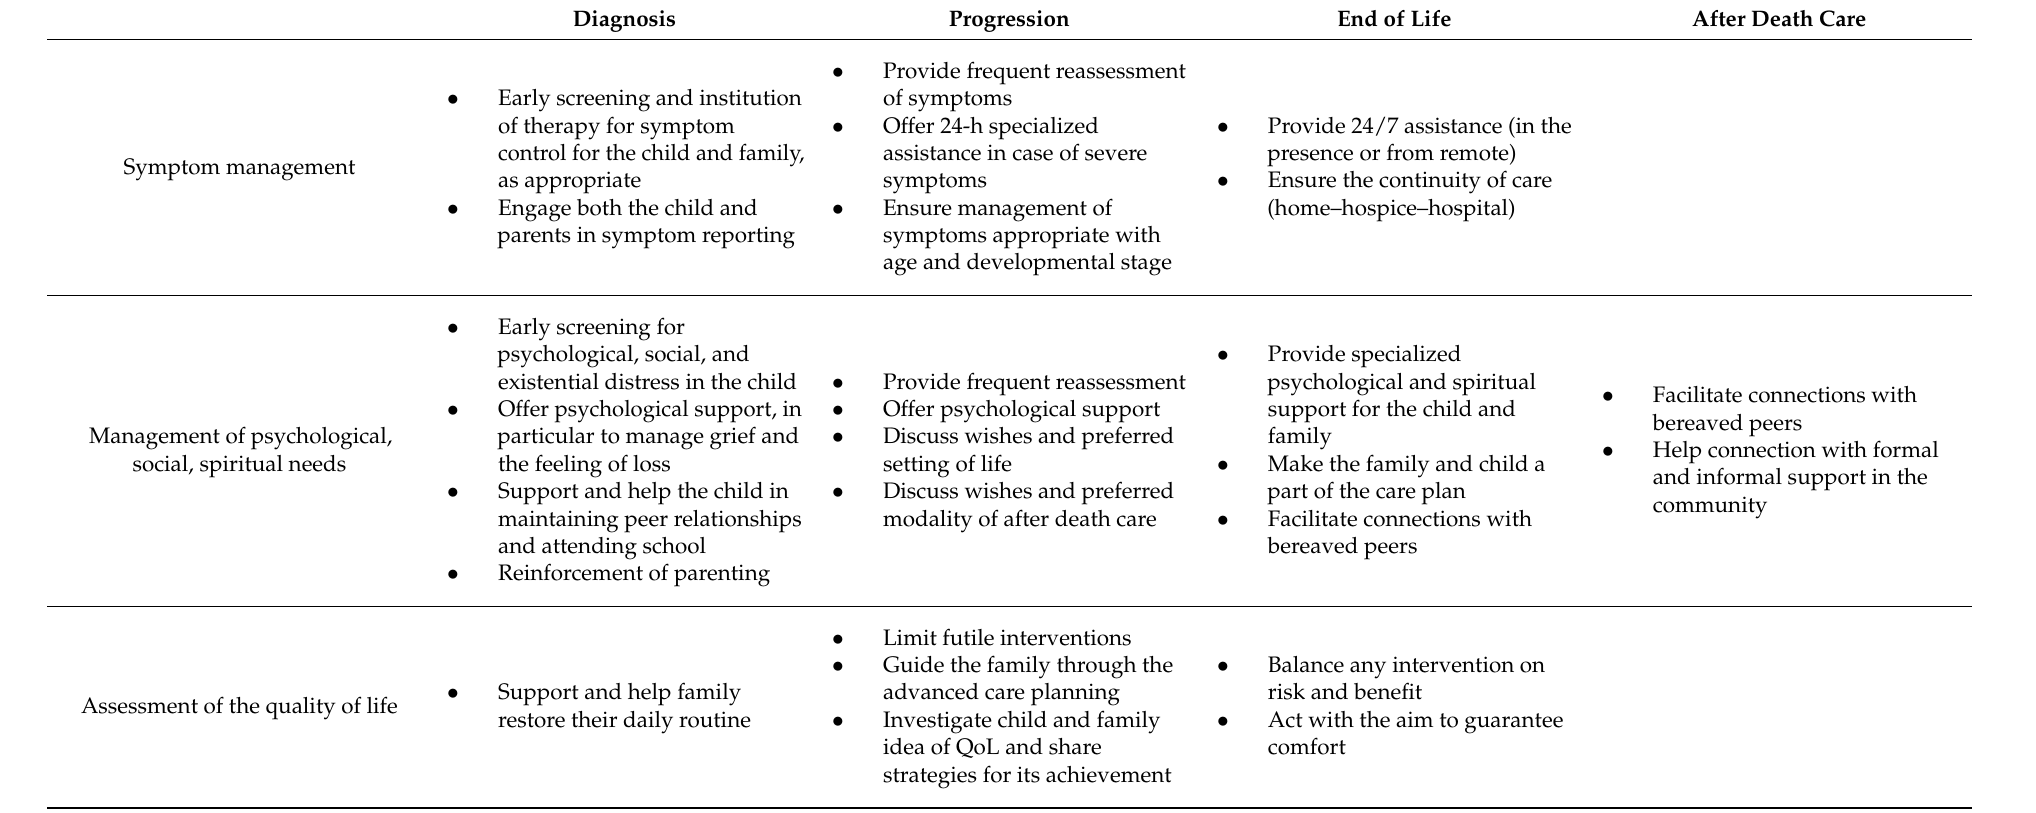
Table 2. Indications according to the different stages of disease and after